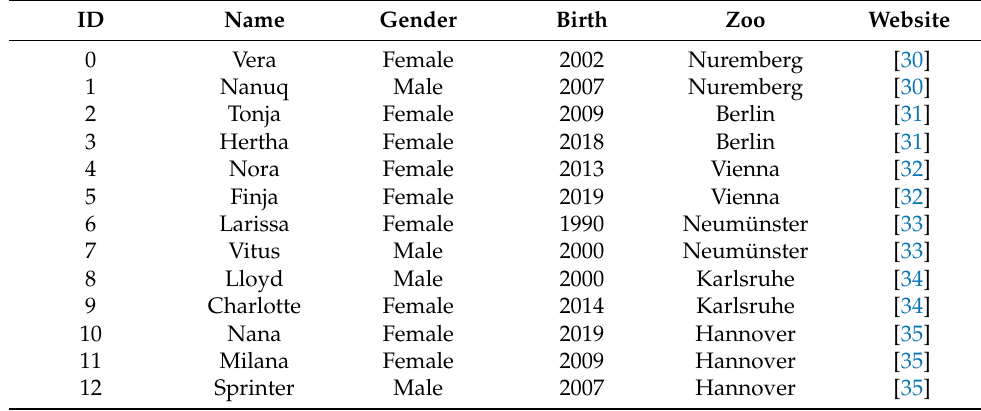
Table 2. Full list of the individual animals in the PolarBearVidID dataset.